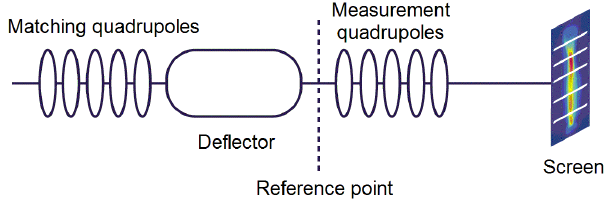
FIG. 3. Schematic overview of the setup for slice emittance measurements at the SwissFEL Injector Test